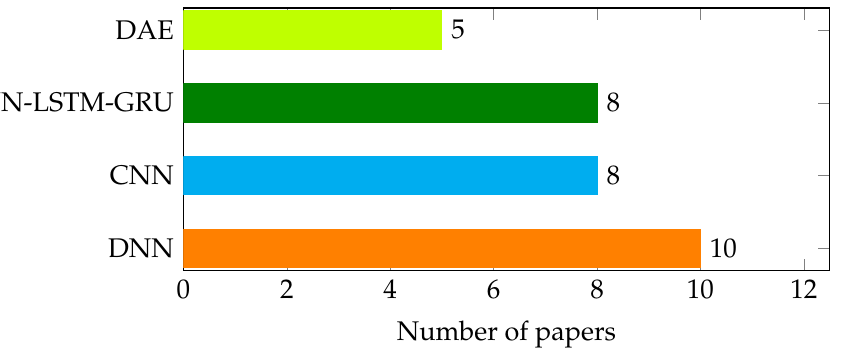
Figure 10. Distribution of reviewed deep learning techniques.